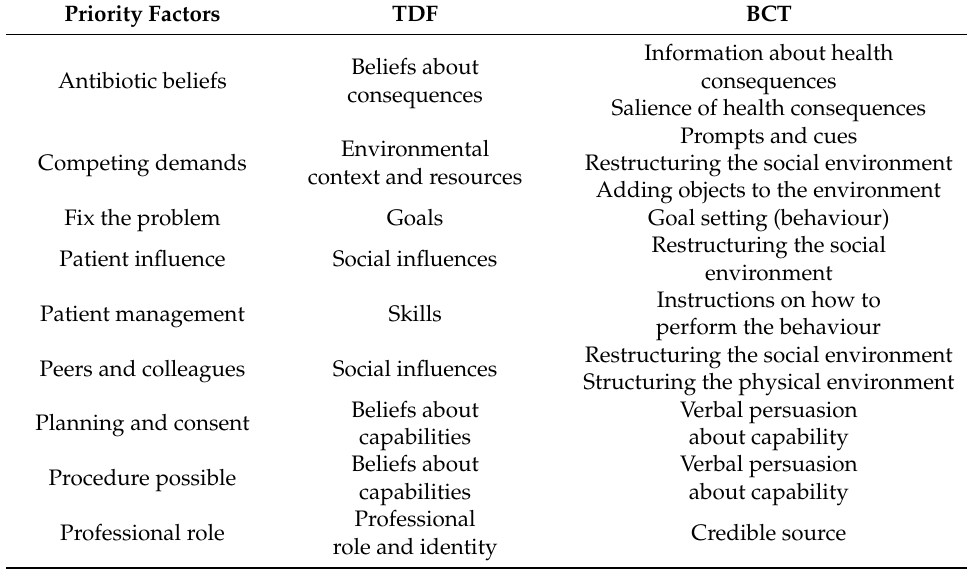
Table 1. Factors that affect decision-making by dentists during urgent dental appointments prioritised for intervention development, mapped to the Theoretical Domains Framework (TDF) and with the selected Behaviour Change Techniques